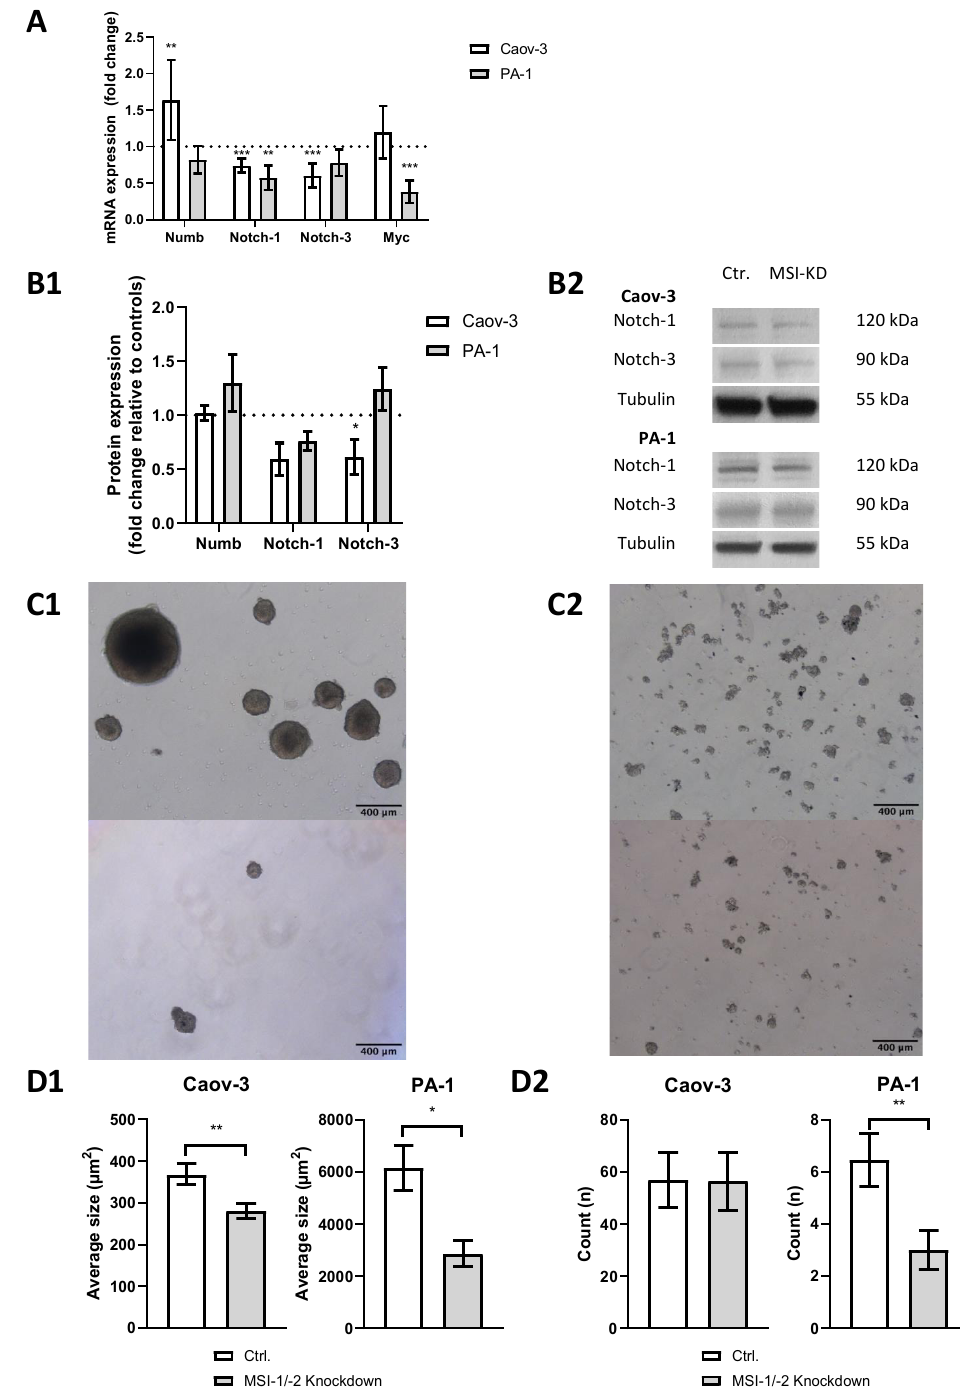
Figure 2. Dual inhibition of Musashi-1 and Musashi-2 impedes cancer stem cell characteristics such as notch pathway gene expression, including pathway elements NOTCH-1 and NOTCH-3 and sphere formation ability. ( A ): Quantitative polymerase chain reaction (qPCR) results. ( B1 ): Western blot results. ( B2 ): Representative western blot staining. All experiments were repeated at least three times in duplicates. ( C1 ): Representative pictures of sphere formation in PA-1 cells (upper picture: control; lower picture: MSI dual knockdown). ( C2 ): Representative pictures of sphere formation in Caov-3 cells (upper picture: control; lower picture: MSI dual knockdown). ( D1 ): The average size of spheres decreases after MSI dual knockdown in Caov-3 and PA-1 cells. ( D2 ): MSI double knockdown leads to a lower count of cell structures in PA-1 cells per microscopic field of view. p values < 0.05 were deemed significant (* p < 0.05; ** p < 0.01; *** p < 0.001, error bars indicate standard error of the mean (s.e.m.)).